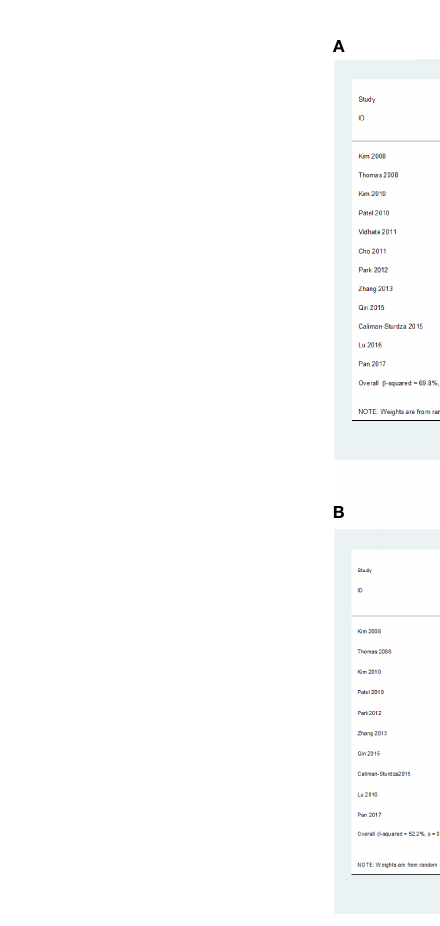
FIGURE 2 | Diagnostic accuracy of the IGRA. For blood IGRAs (A) , pooled sensitivity and speci fi city were 74% (95% CI: 0.65-0.82) and 78% (95% CI: 0.68-0.86), respectively. Moreover, PLR, NLR, and DOR were 3.38 (95% CI: 2.26-5.06), 0.33 (95% CI: 0.23-0.46), and 10.25 (95% CI: 5.46-19.25). For CSF IGRAs (B) , pooled sensitivity and speci fi city were 79% (95% CI: 0.71-0.85) and 95% (95% CI: 0.88-0.98), respectively. In addition, PLR, NLR, and DOR were 16.30 (95% CI: 6.50- 40.83), 0.22 (95% CI: 0.16-0.31), and 57.93 (95% CI: 22.56-148.78),